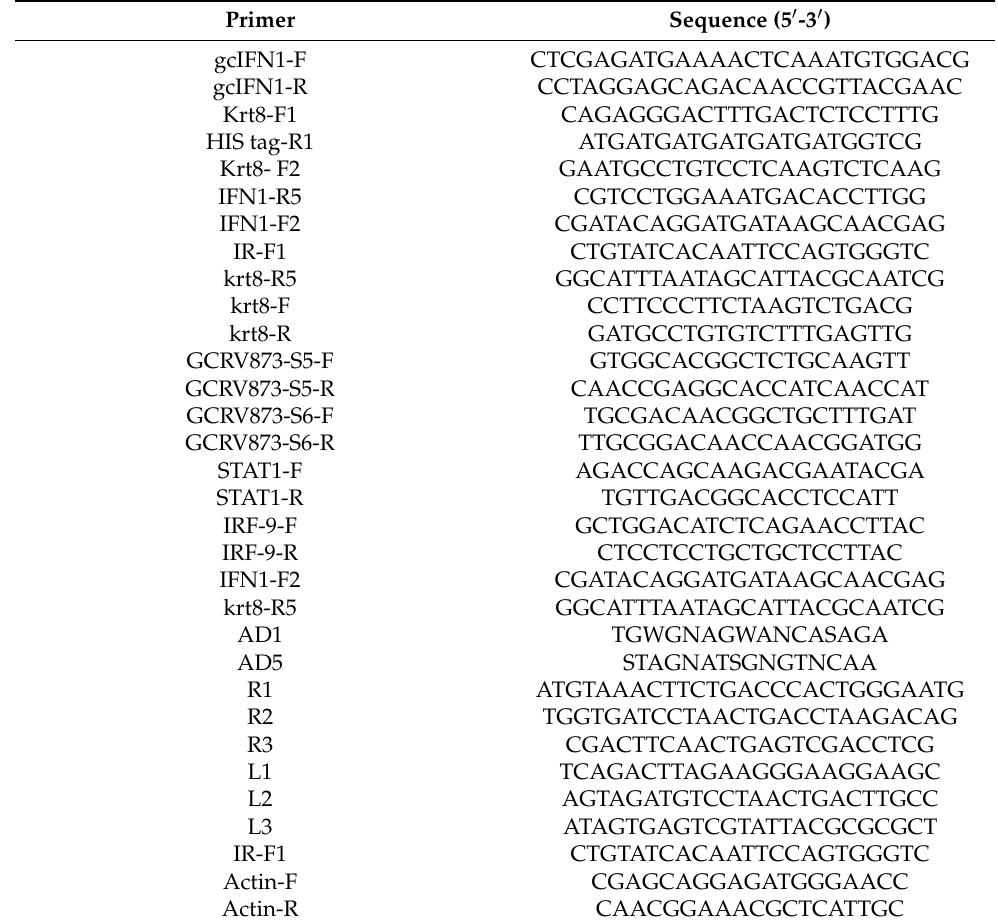
Table 1. Primers used in this study.